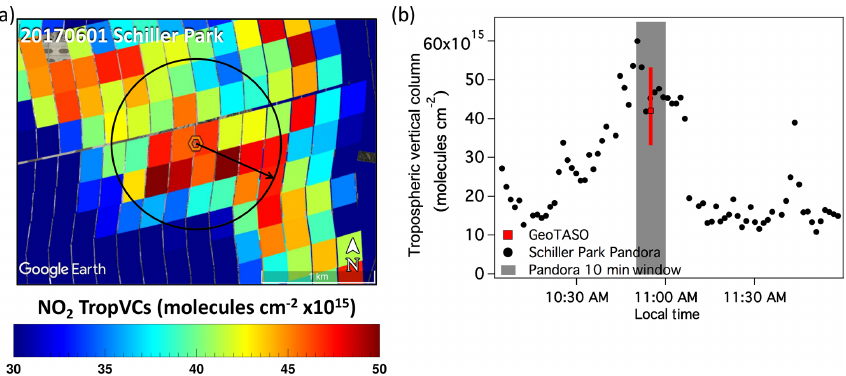
Figure 4. (a) Map of GeoTASO TropVCs on a linear color scale for the Schiller Park overflight on 1 June 2017 at 15:55UTC (10:55LDT) (pink triangle in Fig. 3) with the 750m radius considered in the spatial binning of GeoTASO overlaid and an arrow depicting the Pandora viewing direction (solar azimuth angle) during the overpass time. The Pandora hexagon is colored by the NO 2 TropVC measured by Pandora during the overpass. (b) Time series showing Pandora data (black points) within approximately ± 1h of the GeoTASO overpass. The Pandora temporal window for the coincidence is shaded in gray, and the GeoTASO TropVC and 10th–90th percentiles from the overpass are shown in red. Base map created in ©Google Earth Pro.